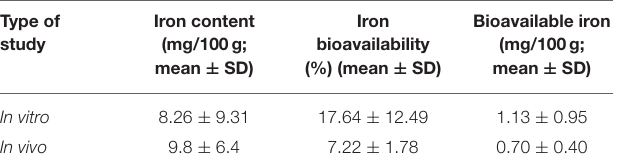
TABLE 2 | Iron bioavailability and bioavailable iron in millets based on the type of study ( in vitro and in vivo ). Type of